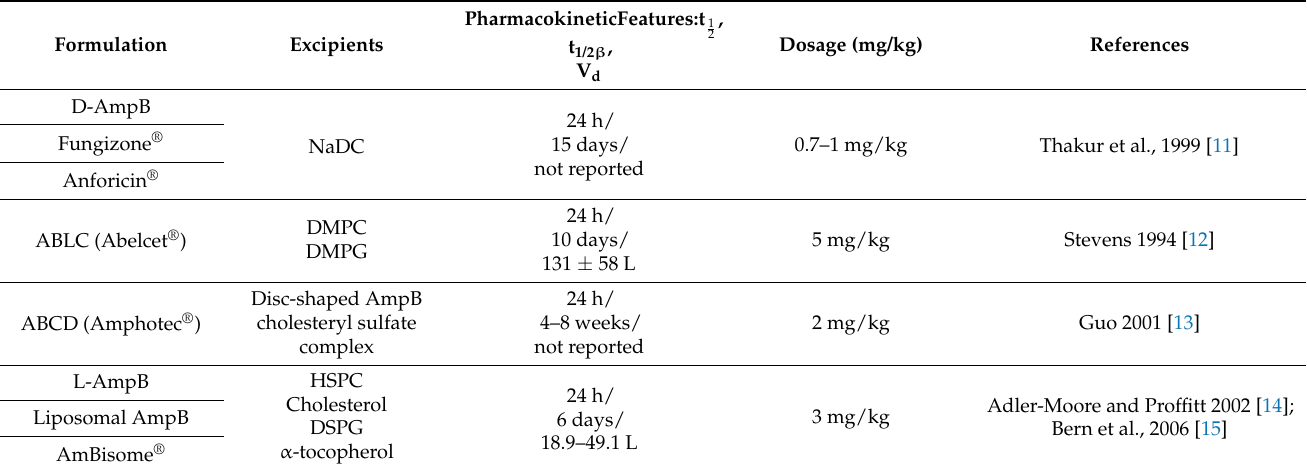
Table 2. Commercial parenteral formulations of